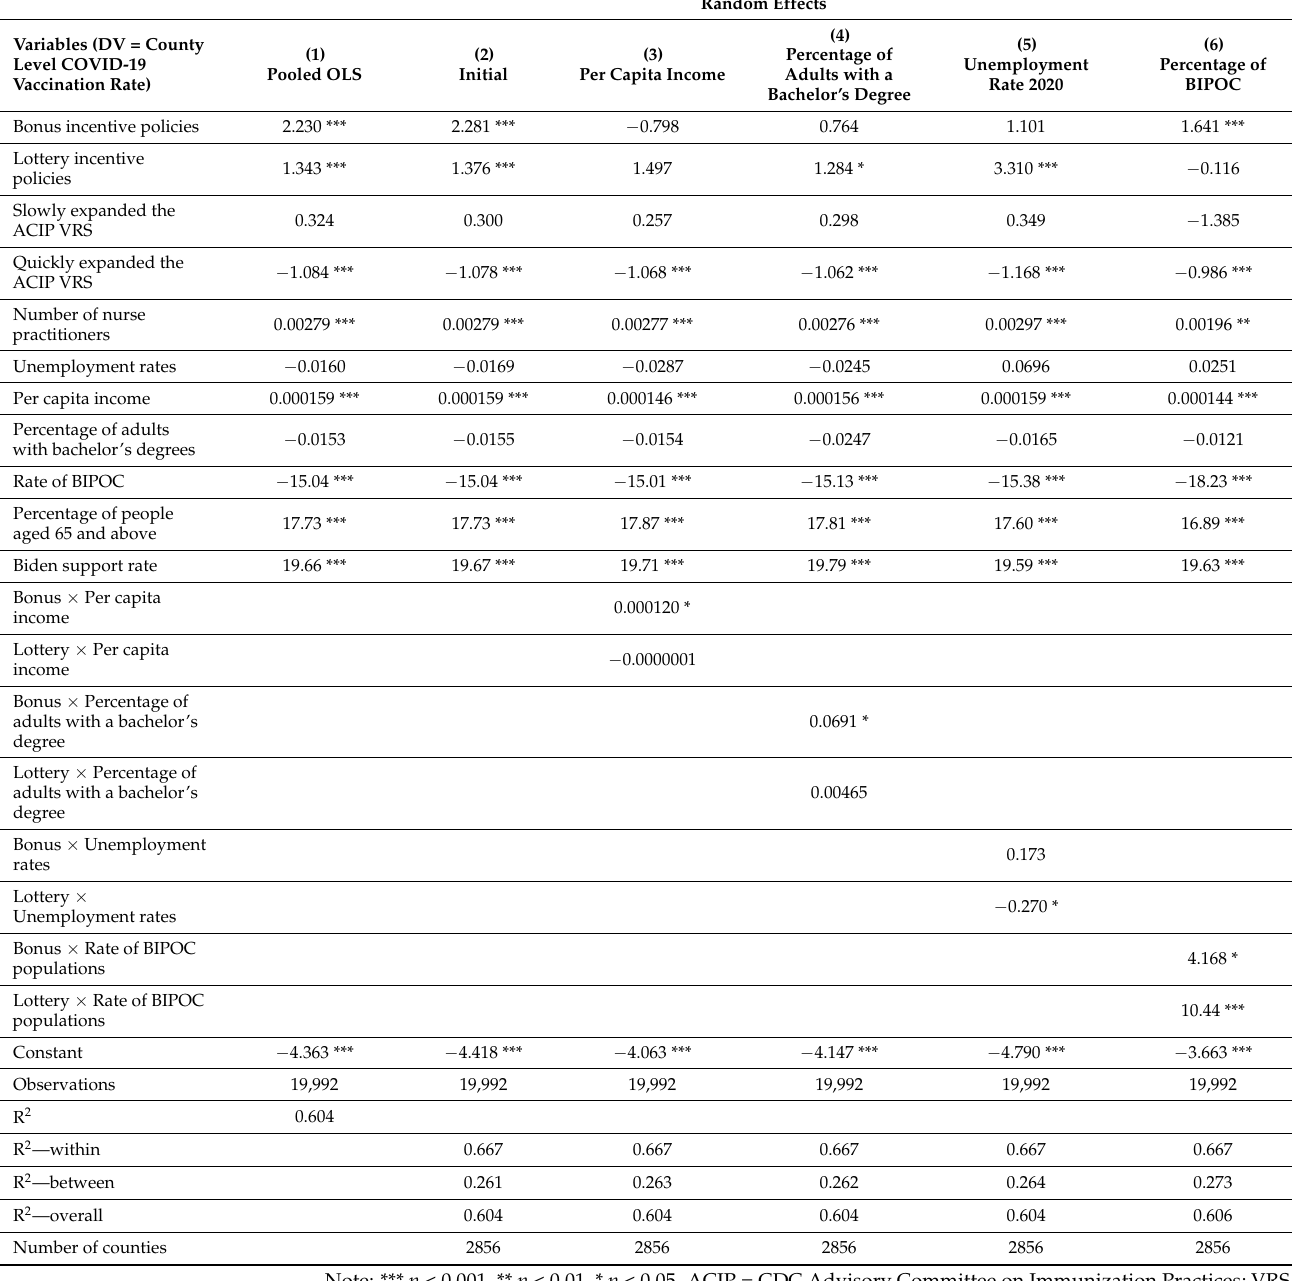
Table 3. Time series analysis of COVID-19 vaccination incentive policies and interaction effects between COVID-19 vaccination incentive policies and socioeconomic